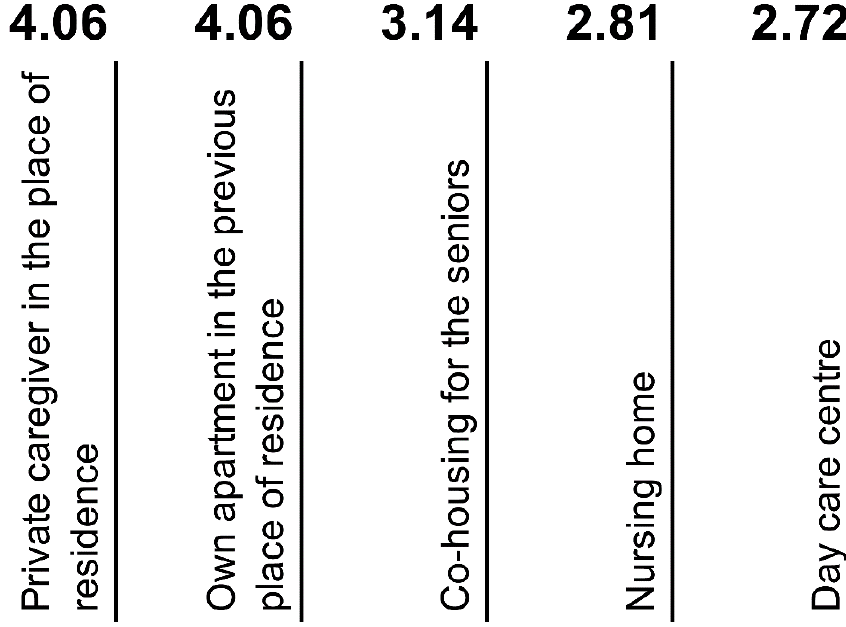
Figure 6. Willingness to change one’s own apartment for an apartment adapted to the needs of the disabled, depending on gender.